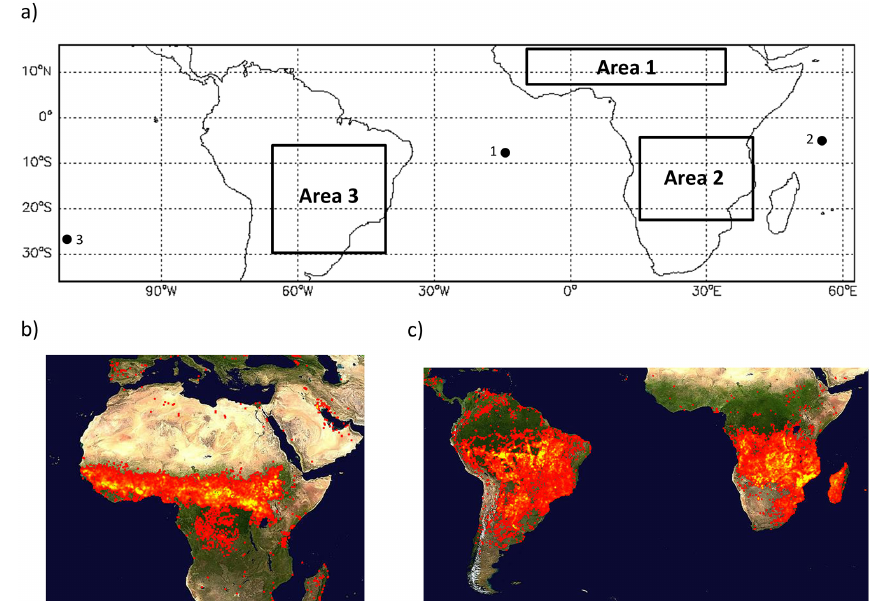
Figure 1. (a) Location of ground-level remote monitoring stations selected for the study: 1. Ascension Island, 2. Mahé, and 3. Easter Island. Locations of biomass burning (Areas 1–3) are also shown. The 10-day fire maps detected by MODIS in (b) January (21–30 January 2005) and (c) September (8–17 September